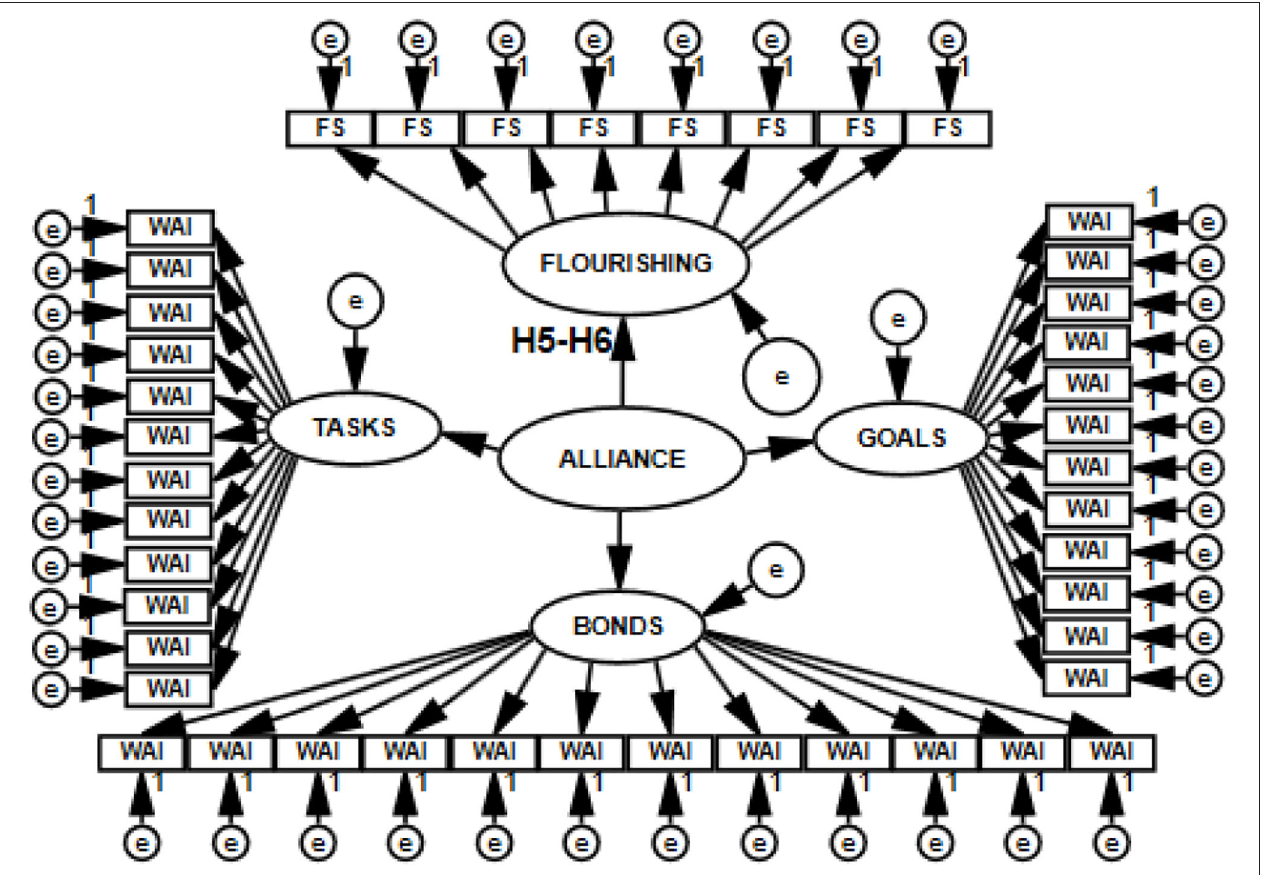
FIGURE 5 | Structural and measurement model with five latent variables postulating the direction of relations between the working alliance and flourishing, tested with SEM.